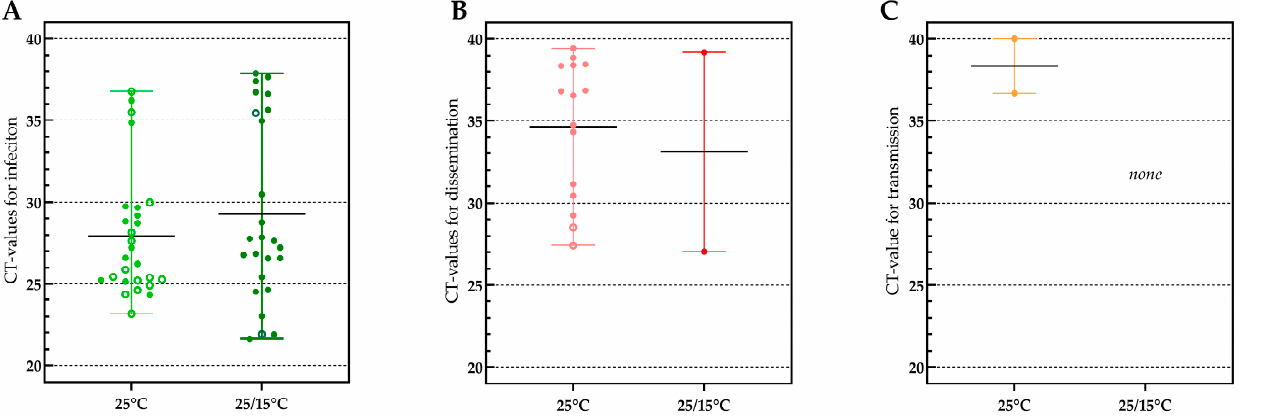
Figure 4. Viral loads (CT-values) found in samples of Culex pipiens mosquitoes found positive for infection ( A ), dissemination ( B ) and transmission ( C ). Mean CT’s are indicated by horizontal black lines. Open circles in panel A and B indicate individual mosquitoes that tested positive in dissemination and transmission, respectively. Filled dots in panel A and B indicate individual mosquitoes that tested negative in dissemination and transmission,